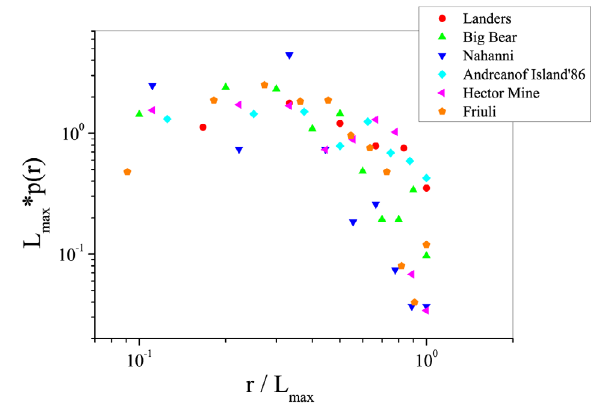
Figure 3. Frequency distribution p ( d ) versus main shock-aftershock distance r , for the selected